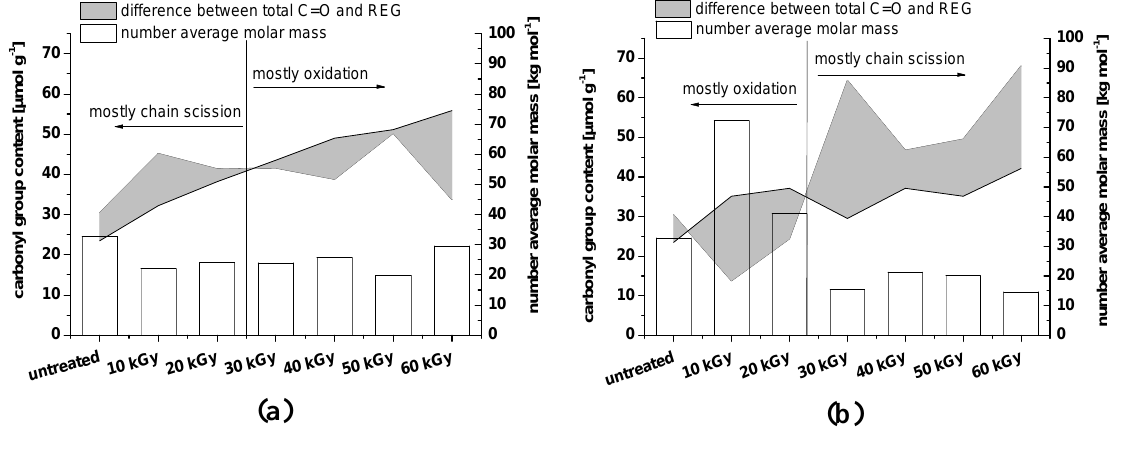
Figure 4. Content of REG compared to the total amount of carbonyl groups (determined by fluorescence labeling). The shaded area corresponds to the difference between total C=O and REG, representing oxidation on the cellulose backbone (when the shaded area expands below the black line). As the calculation of REG is based on the number average ), the data are shown as well (empty bars). ( a ) NCC wet; ( b ) NCC dry. The molar mass ( M n untreated material is identical in the two